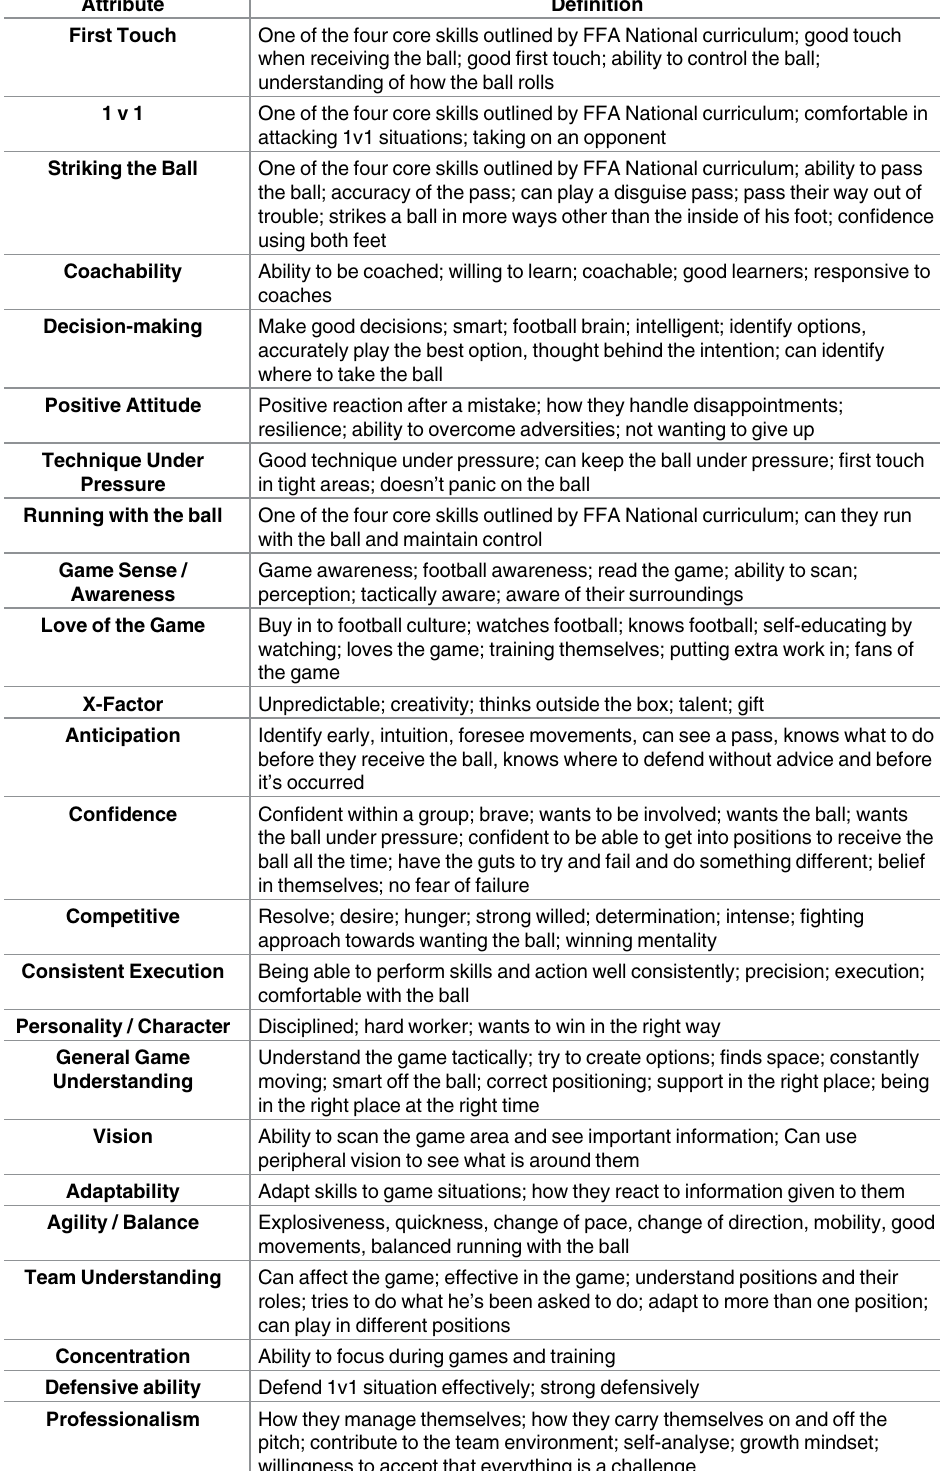
Table 1. The operational definitions of each attribute as identified by meaning units provided by the participants during the interview